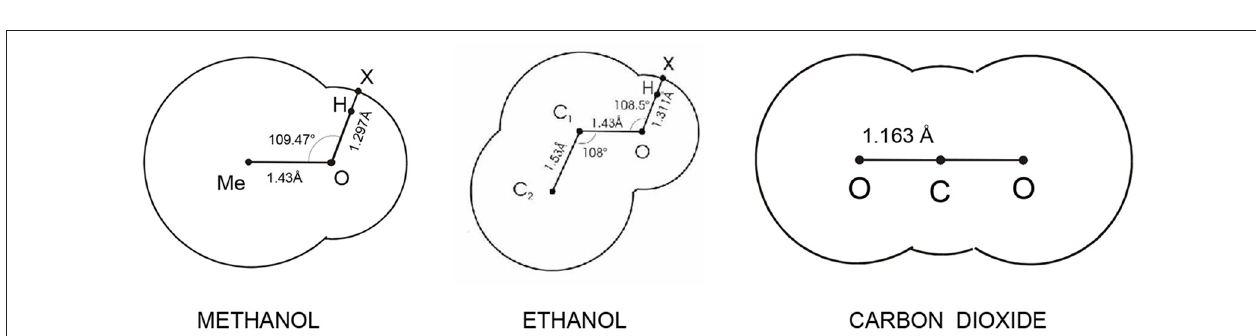
FIGURE 6 | Primitive models descending from realistic force fields.